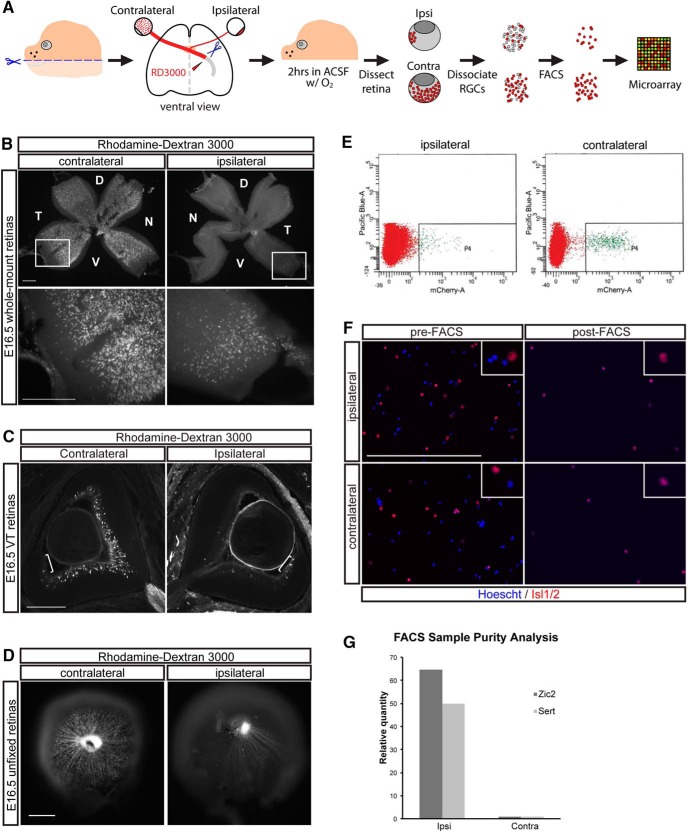
FACS purification of retrogradely labeled mouse retinal ganglion cells at E16.5. A, Schematic of retrograde labeling and cell purification methods for microarray analysis. Diagram of the ventral view of embryonic brain depicts application of rhodamine dextran 3000 MW dye (RD3000) to a unilateral transected optic tract. B, Whole-mount preparations of E16.5 retina. RD3000 fully labels axons and cell bodies of E16.5 RGCs within 2 hours of incubation after dye application to the optic tract. Extra-VT RGCs are labeled in retina contralateral to labeled optic tract and VT RGCs are labeled in the ipsilateral retina. C, Coronal vibratome sections of E16.5 retina retrogradely labeled with RD3000 show specific labeling of contralateral and ipsilateral RGCs in their respective retinal domains (VT domain marked with white bracket). D, Fresh E16.5 retinas are screened for appropriate RD3000 labeling of ipsilateral and contralateral RGCs before FACS. E, FACS purification of ipsilateral and contralateral RGC populations retrogradely labeled with RD3000 with DAPI exclusion of nonviable cells. ∼3000 ipsilateral and ∼20,000 contralateral RGCs (P4 gate) are purified from two litters of E16.5 embryos. F, Cells purified by FACS are enriched in RGC marker Islet1/2 compared with presorting. G, Zic2 and SERT are enriched in the ipsilateral RGC cell population isolated by FACS compared with the contralateral RGCs. D, dorsal, V, ventral, N, nasal, T, temporal. Scale bars, 250 μm.